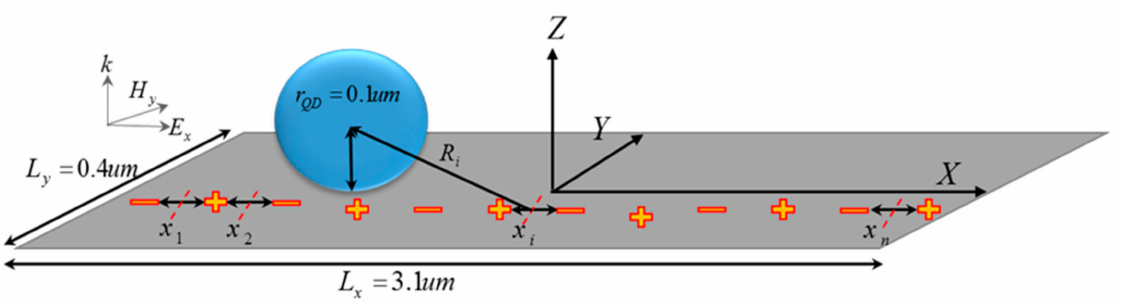
Figure 3. The structure under study with induced